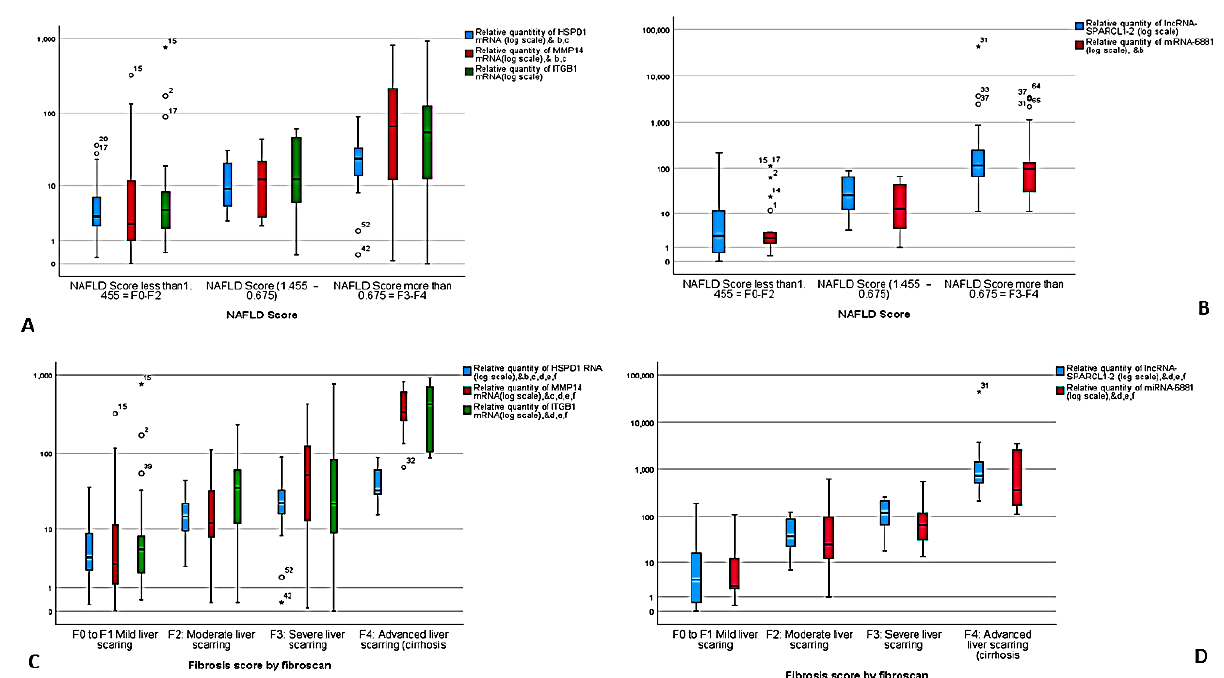
Figure 4. Differential expression in different NAFLD scores of HSPD1 mRNA, MMP14 mRNA, ITGB1 mRNA ( A ), miR-6881-5p miRNA and lnc-SPARCL1-1:2. * Statistically significant difference ( p < 0.05) by Tukey post-hoc test, b NAFLD score 1 vs. 3, c NAFLD score 2 vs. 3. ( B ), and differential expression in different fibrosis scores of HSPD1 mRNA, MMP14 mRNA, ITGB1 mRNA ( C ), miR-6881-5p miRNA and lnc-SPARCL1-1:2 ( D ). * statistically significant difference ( p < 0.05) by Tukey post-hoc test, b Fibrosis stage 2 vs. Fibrosis stage 3, c Fibrosis stage 1 vs. Fibrosis stage 3, d Fibrosis stage 1 vs. Fibrosis stage 4, e Fibrosis stage 2 vs. Fibrosis stage 4, f Fibrosis stage 3 vs. Fibrosis stage 4. Table 3. Showing multivariate regression